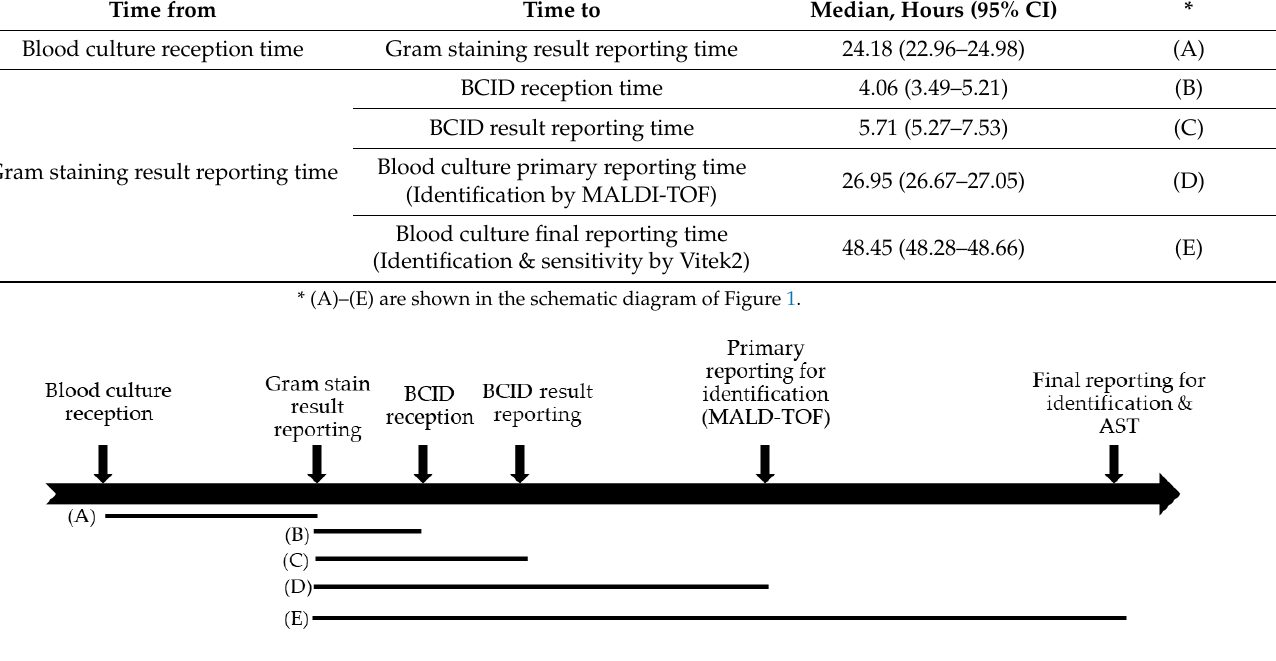
Table 6. Turnaround time from positive blood culture bottles using conventional methods or BCID. Time from